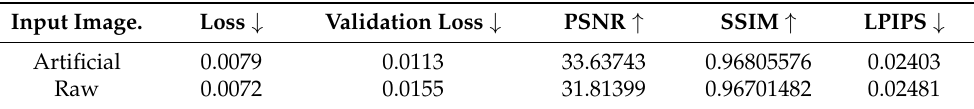
Figure 5. Quality comparison between the colorization result from the raw image and the artificial image. ( a ), ( b ), ( c ), ( d ), and ( e ) refer to the input raw image, input artificial image, predicted colored image using the artificial image, and ground truth RGB image, respectively. Table 4. Comparison of the colorization performance of the artificial image and raw-image-based models on the COMPASS-XP dataset in terms of PSNR, SSIM, and LPIPS. Input